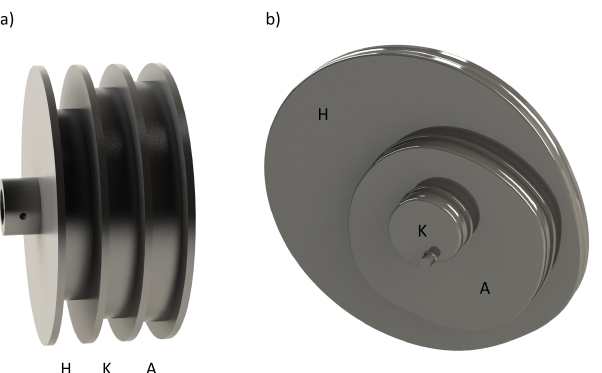
Figure 6. Transmission system for synergy-based actuation in exosuits. ( a ) Kinematic synergies. ( b ) Dynamic synergies. A: ankle; K: knee; H: